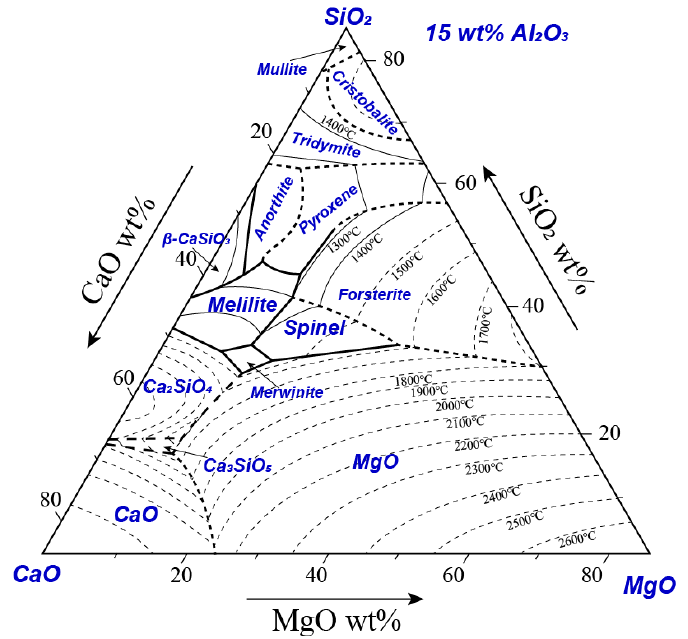
Figure 5. Pseudo-ternary phase diagram CaO-MgO-Al 2 O 3 -SiO 2 for the 15% Al 2 O 3 plane [7].